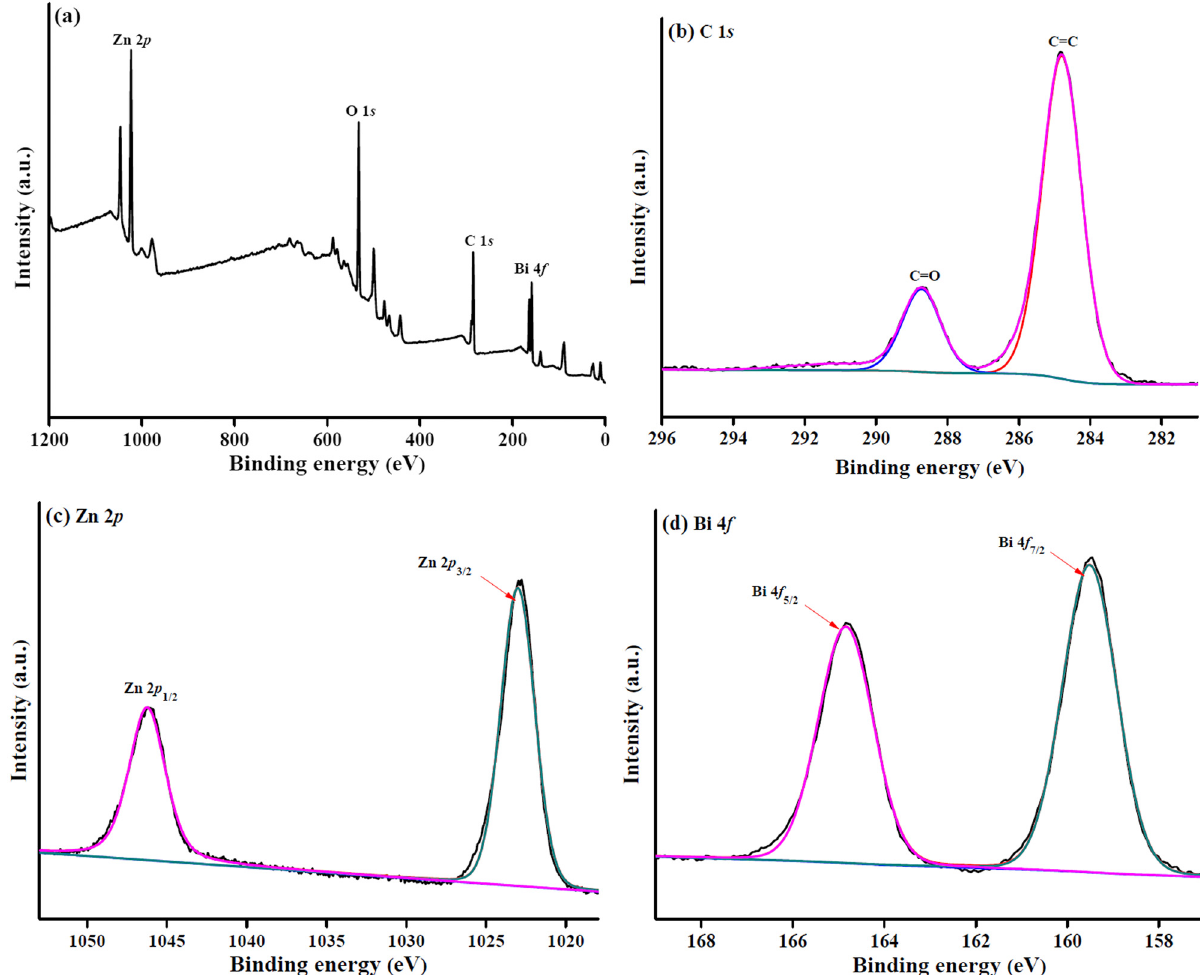
Figure 4: XPS full spectrum ( a ) , C 1s spectrum ( b ) , Zn 2p spectrum ( c ) , and Bi 4f spectrum ( d ) of the Bi 2 O 3 @Zn - MOF - 2 composite.